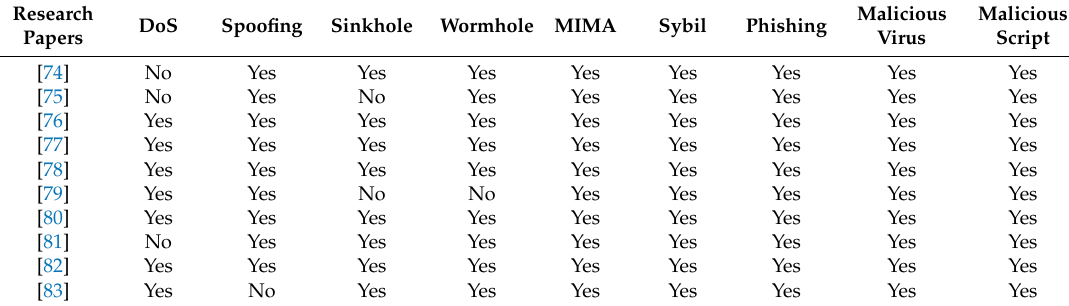
Table 3. Attacks on GSB/RSB